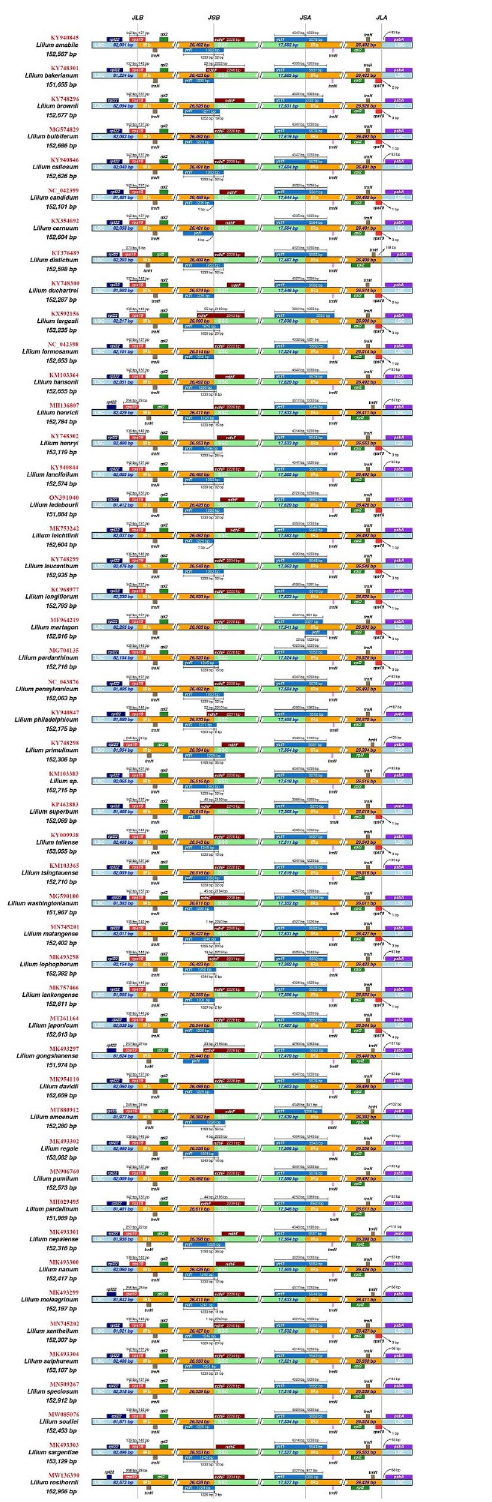
Figure 2. Comparison of the junction positions of LSC, SSC, and IR regions among the among 48 Lilium cp genomes. The red identifiers represent the GenBank accession number of each